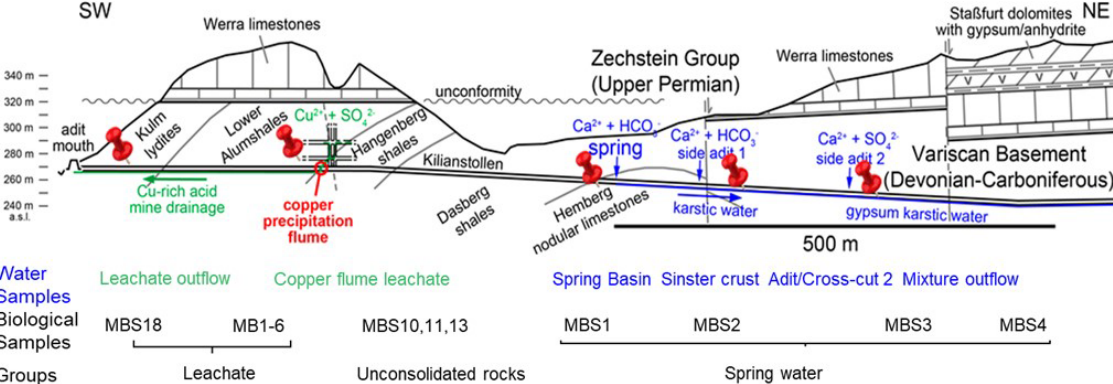
Figure 1. Simplified geological section of the Kilianstollen (Marsberg) and formation of different ground waters. Folded Devonian– Carboniferous lydites, shales, and nodular limestones of the Variscan Basement are unconformably overlain by Upper Permian carbonates and evaporites of the Zechstein Group. The reduced transition metals (Cu, Fe, Mn) from fault-bound breccias and black shales are oxidized, resulting in copper-rich acidic mine waters (Emmerich, 1987), draining towards the adit entrance in SW direction. Some of the mine waters (flowing in NE direction) are enriched in calcium, hydrogen carbonate, and sulfate ions, depending on the rocks (limestone and gypsum) in contact. The geological section is based on (Îskar and William, 1936; Stribrny, 1987; Stribrny and Urban, 2000; Farrenschon et al., 2008) and an unpublished mining map. The red pins mark the location of the sampling sites along the mine drainage system for both water and biological samples collections. The biological samples were further classified into three groups based on their origin and nearby